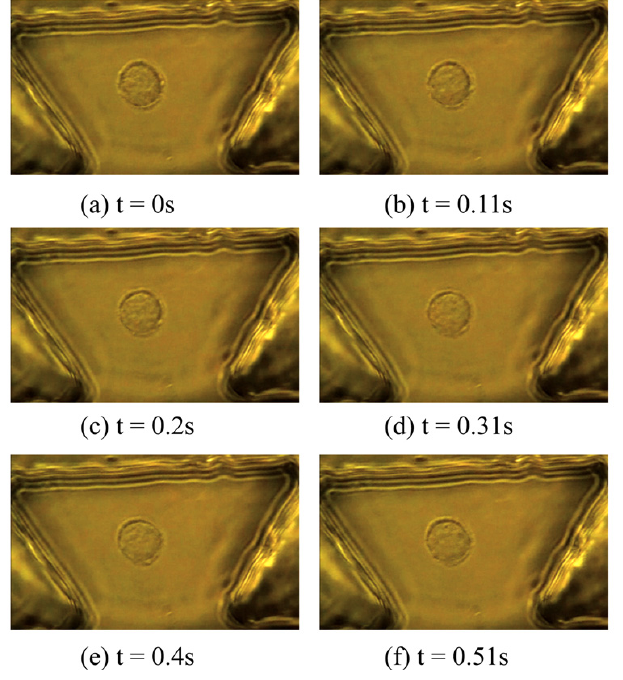
Figure 6. Time series images demonstrating the controlled rotation of a CP-C cell through 180° over 0.51